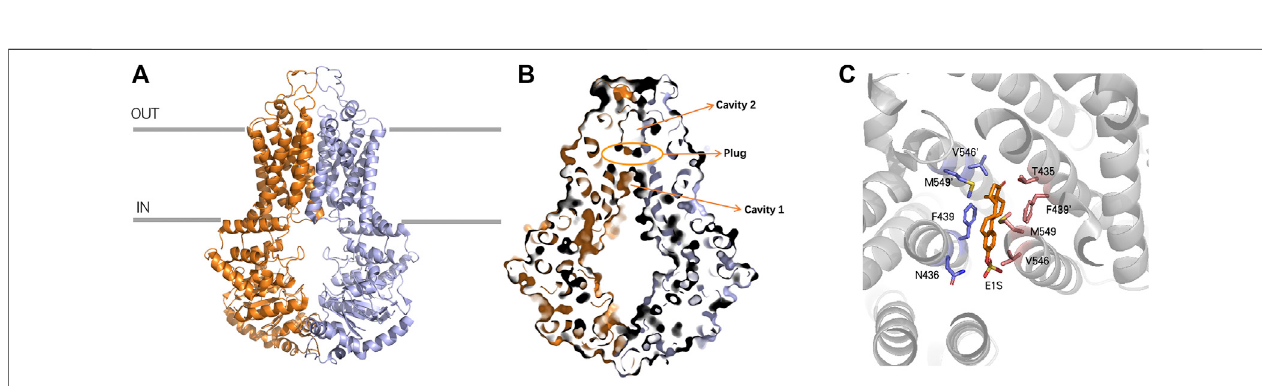
FIGURE 2 | Ribbon representation of the ABCG2 structure (A) ribbon representation of the ABCG2 structure, with the two halves of ABCG2 colored purple and orange, respectively. (B) Surface representation of cavity 1, cavity 2 and Leucine plug (C) ABCG2 binds with E1S and the residues F439 and N436 can form stacking interactions and hydrogen bond with E1S,